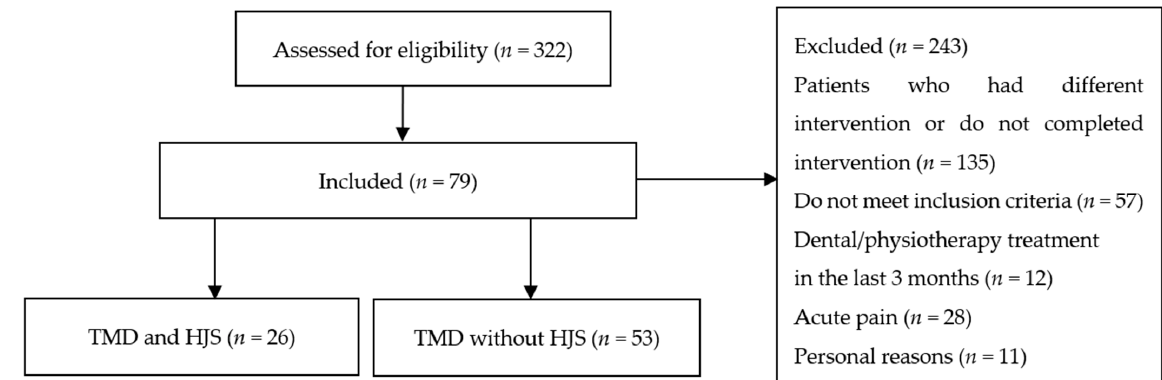
Figure 1. Participants allocation to the clinical part of the study. HJS—Hypermobility Joint Syndrome; TMD—Temporo- mandibular Disorders.